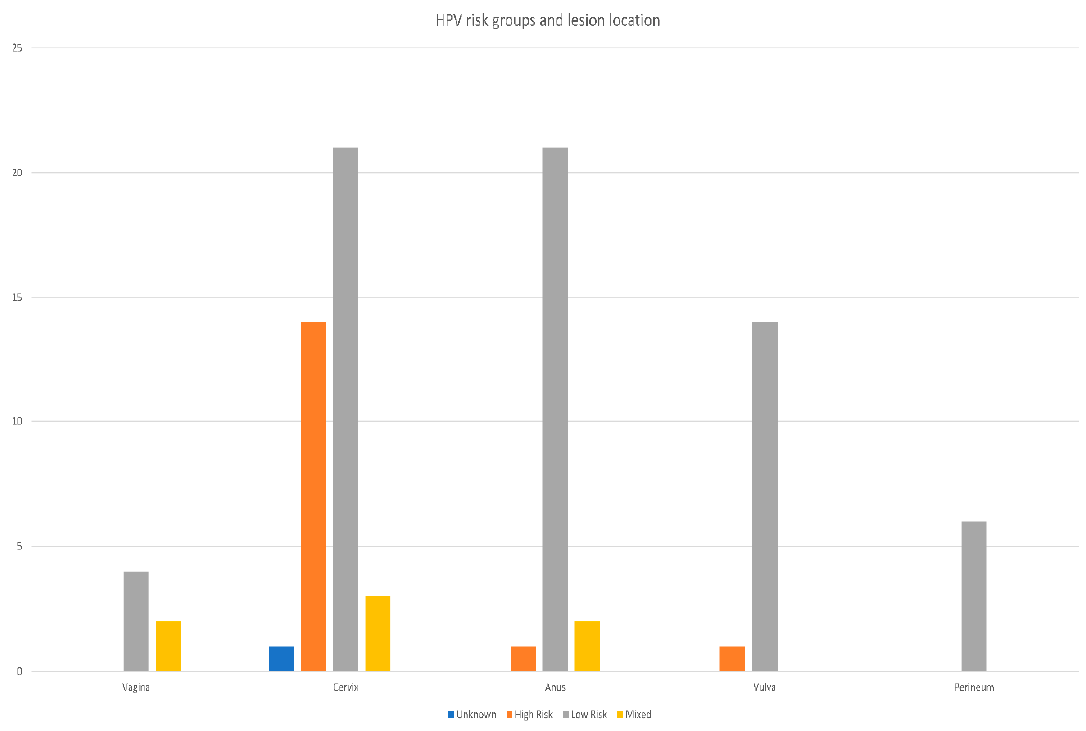
Figure 2. HPV risk groups in relation to anatomical location.